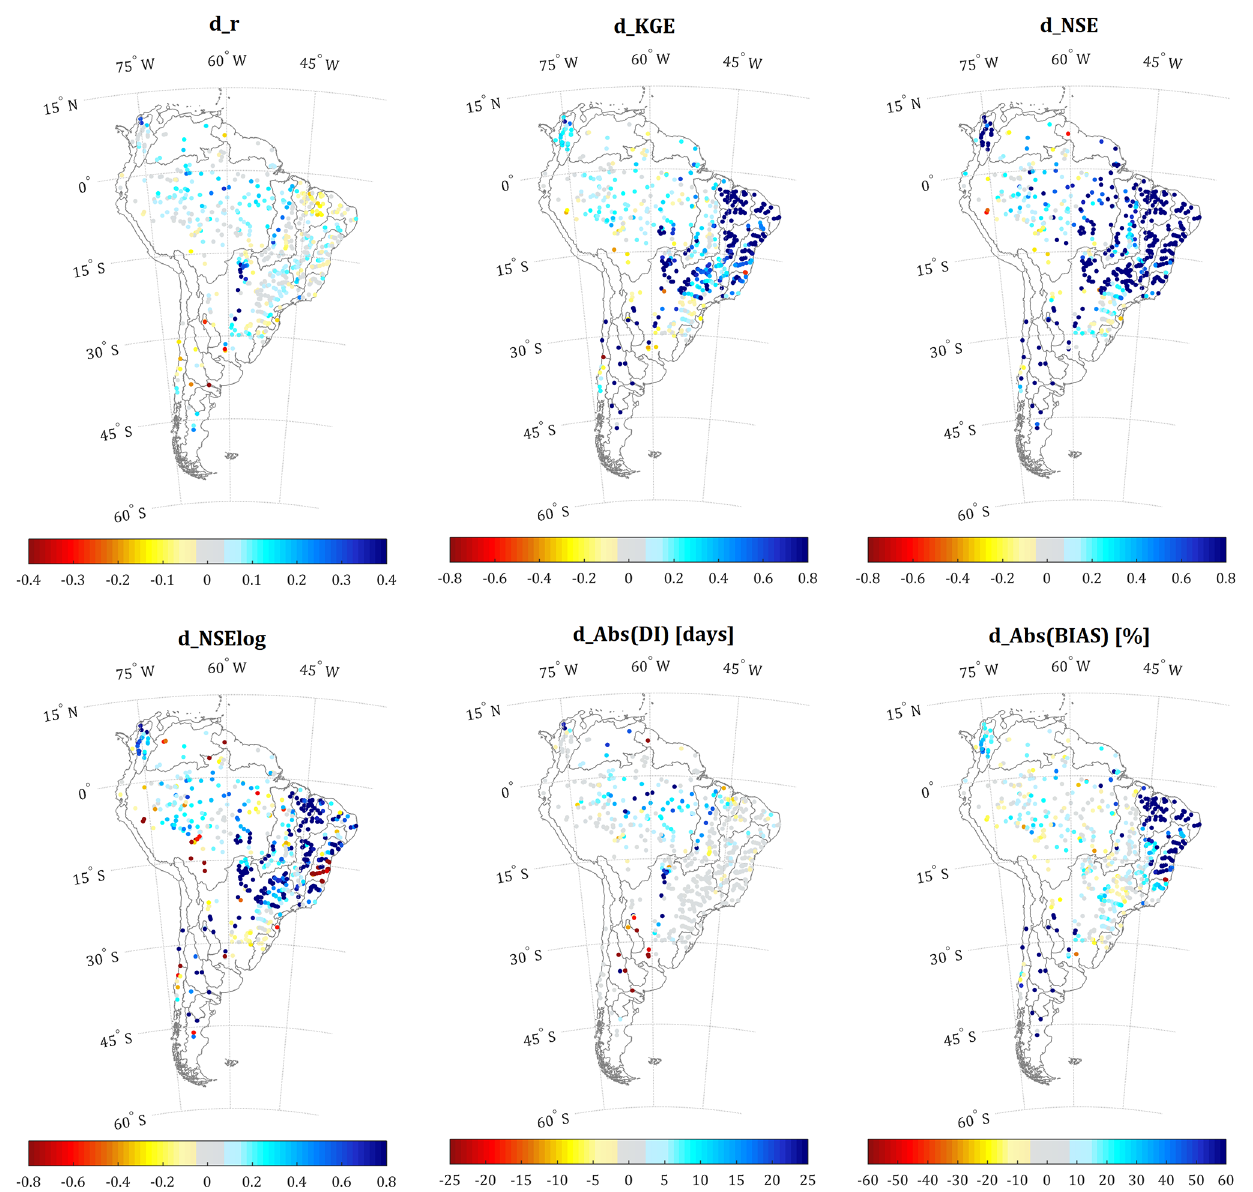
Figure 10. Difference between performances of MGB and the Ensemble GM for discharge metrics. Values considered as not significant (gray) are within the ranges − 0 . 05 to + 0 . 05 (d_r, d_KGE, d_NSE and d_NSElog), − 5% to 5% (d_Abs(BIAS)) and − 2 to + 2 days